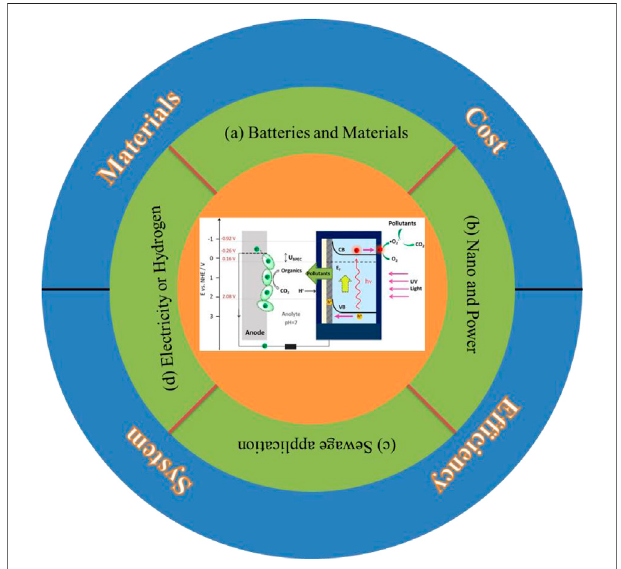
FIGURE 6 | Research hotspots for photocatalytic microbial fuel